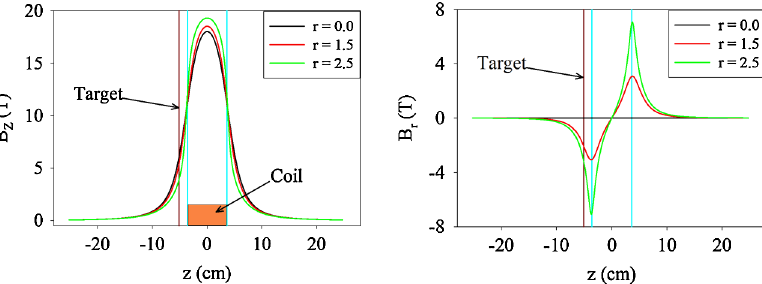
target.FIG. 3. Longitudinal (left) and transverse (right) components of the solenoidal field along the axis for different radii in cm; the geometric length of the solenoid (cyan lines) as well as the target position (brown line) are marked.